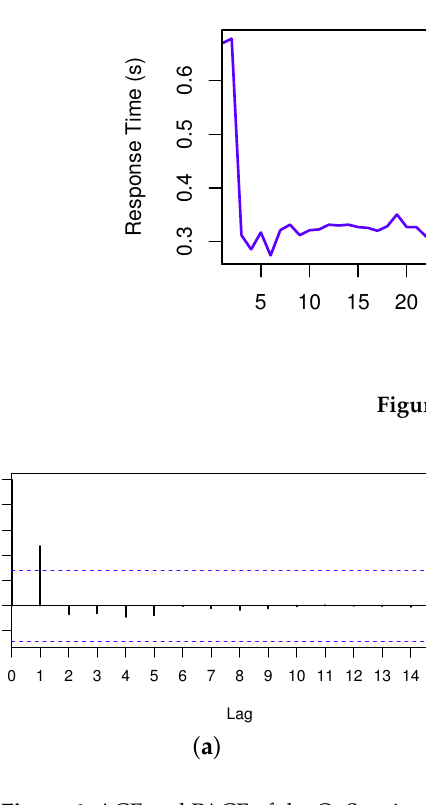
Figure 6. ACF and PACF of the QoS series. ( a ) ACF of the QoS series; ( b ) PACF of the QoS series.